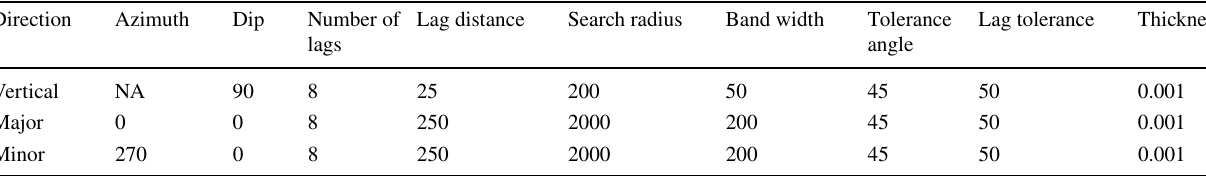
Table 7 Experimental variogram computation for final pore pressure cubes Direction